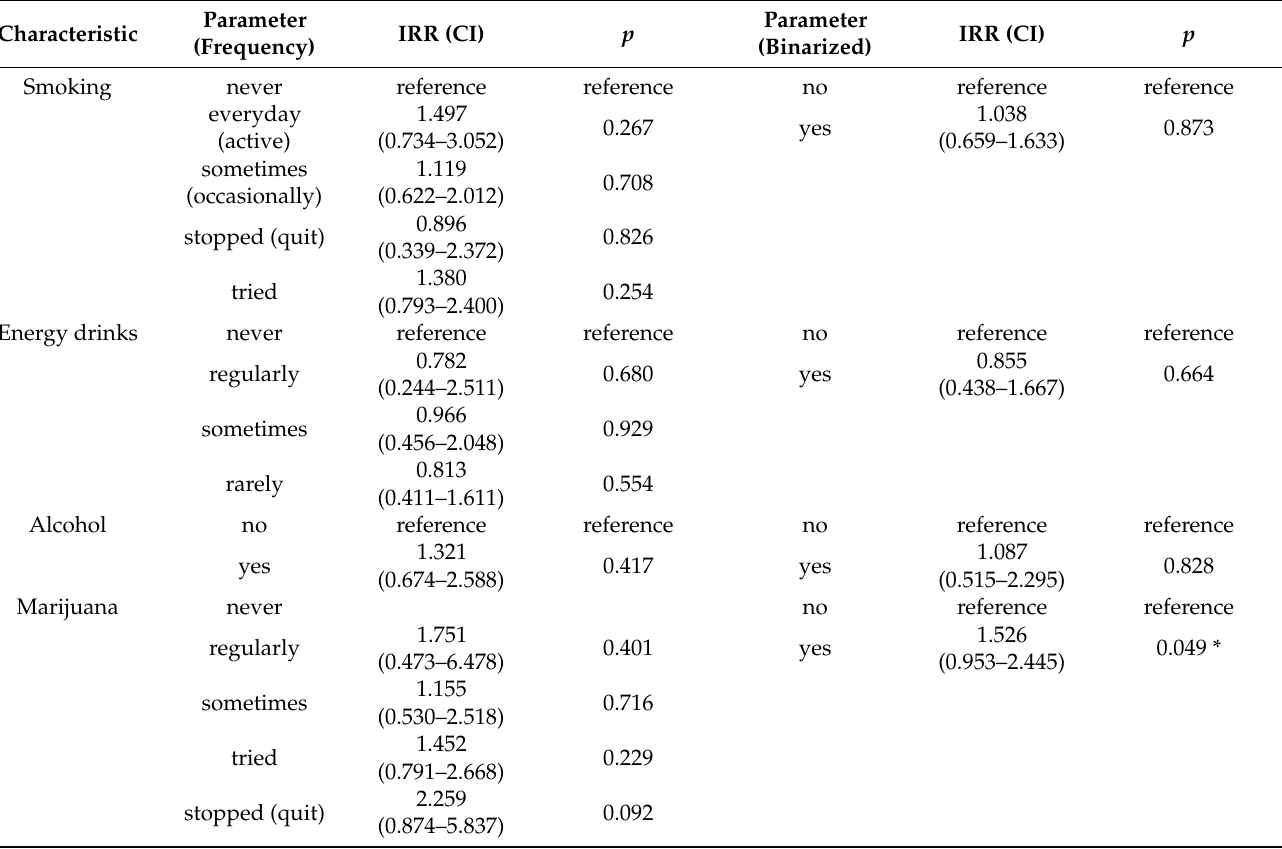
Table 5. Habits regarding (il)legal psychoactive substances (ab)use as predictors of NPS awareness among Serbian future HCPs—negative binomial model ( p -value) and incidence rate ratios (IRR) with 95% confidence intervals (CI).